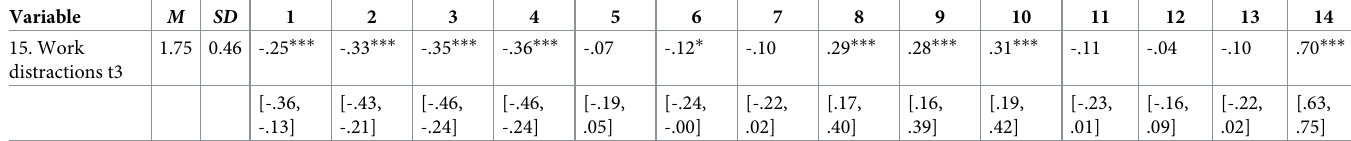
M and SD represent mean and standard deviation, respectively. Values in square brackets indicate the 95% confidence interval for each correlation. * indicates p < .05. ** indicates p < .01, *** indicates p < 0.001.